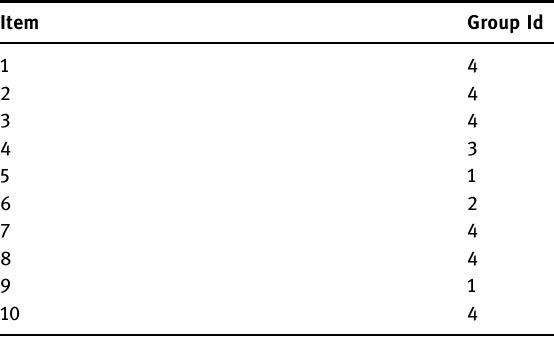
Table 6: Item grouping for vertical partitioning of database